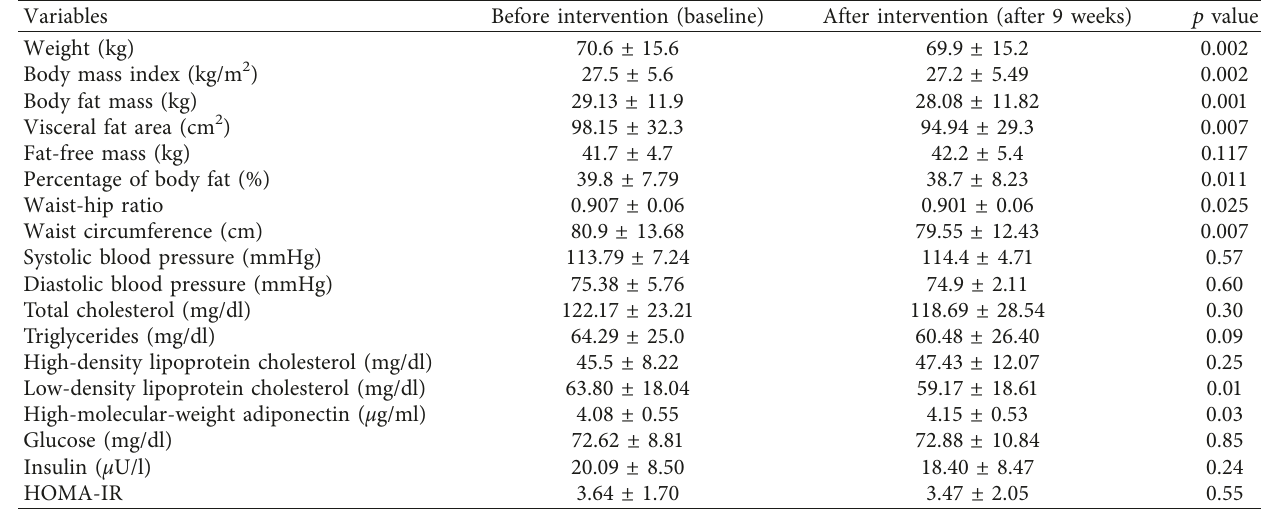
Table 1: Changes in the anthropometric measurements, blood pressure, and biochemical measurements of participants before and after intervention ( N � 52).